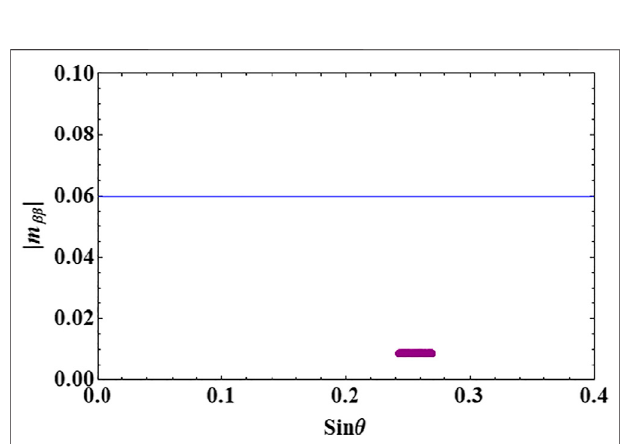
FIGURE 4 | Prediction of the effective neutrino mass as a function of the TM 1 mixing parameter sin θ